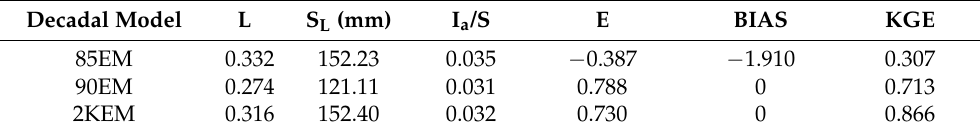
Table 2. The optimum S (S L ), L, I a to S ratio, Nash–Sutcliffe index, bias, and KGE index for each decadal dataset in East Malaysia.